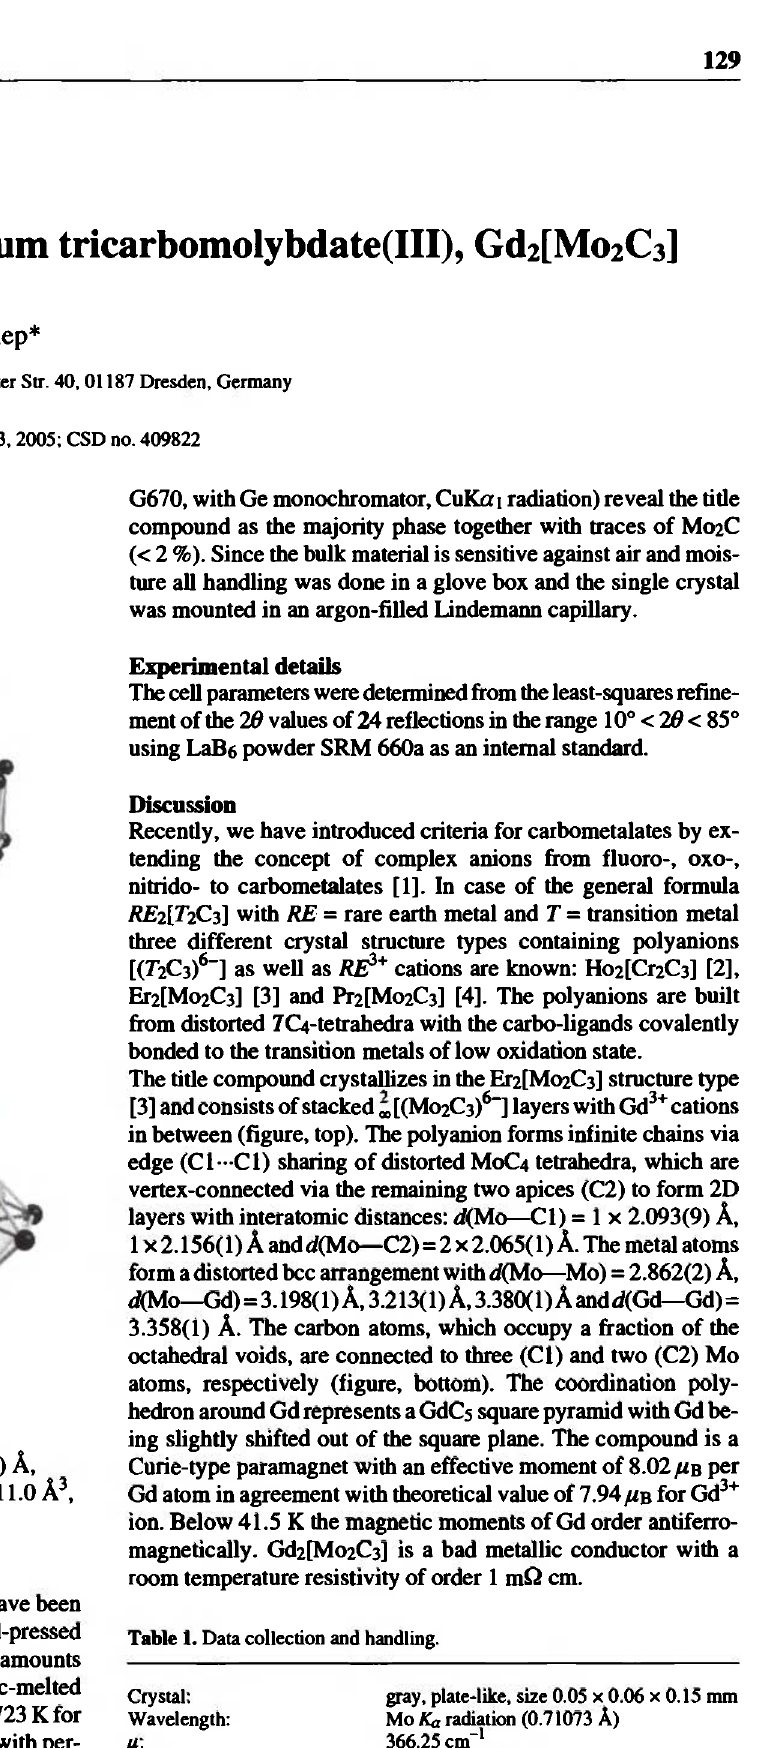
Table 1. Data collection and